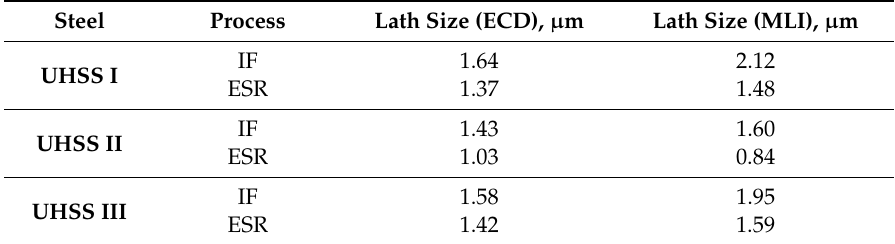
Table 8. ECD and MLI lath sizes.